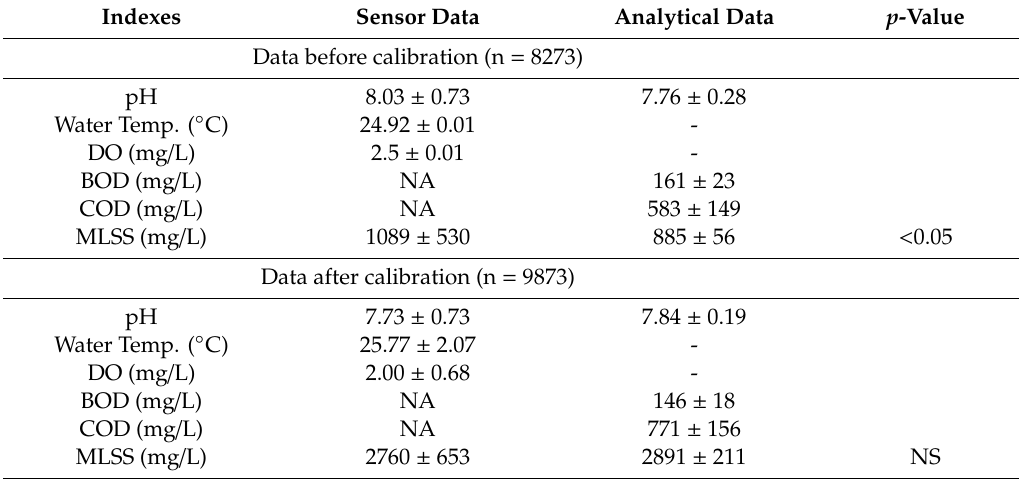
Table 5. Comparison of the wastewater quality indexes in the SBR before / after calibration of water quality sensors.